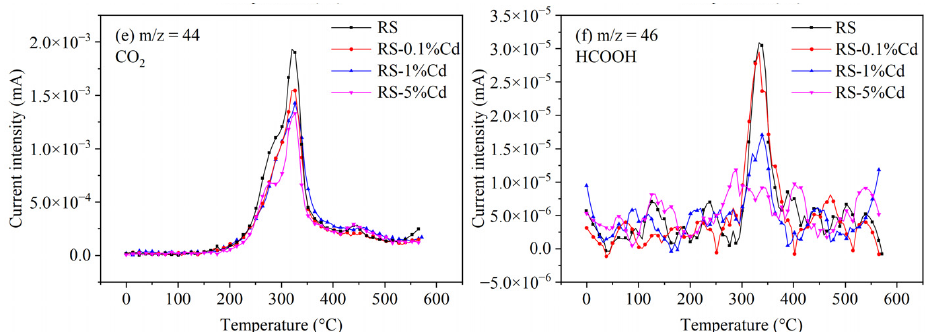
Figure 10. Release characteristics of gaseous products from rice straw with different Cd loading. ( a ) is the CH 4 ; ( b ) is the H 2 O; ( c ) is the CH 2 O; ( d ) is the CH 3 OH; ( e ) is the CO 2 ; ( f ) is the HCOOH, respectively.